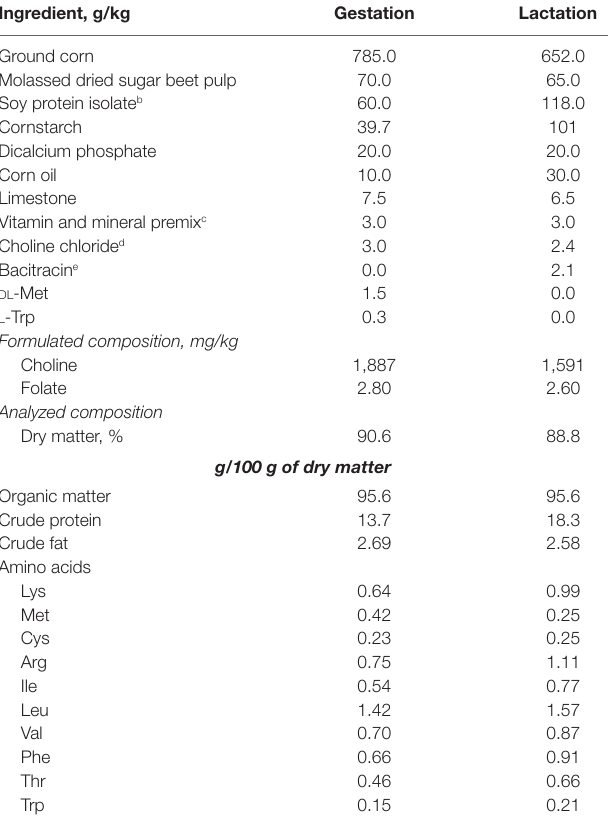
TaBle 1 | Formulated and analyzed composition of gestation and lactation diets. a ingredient,